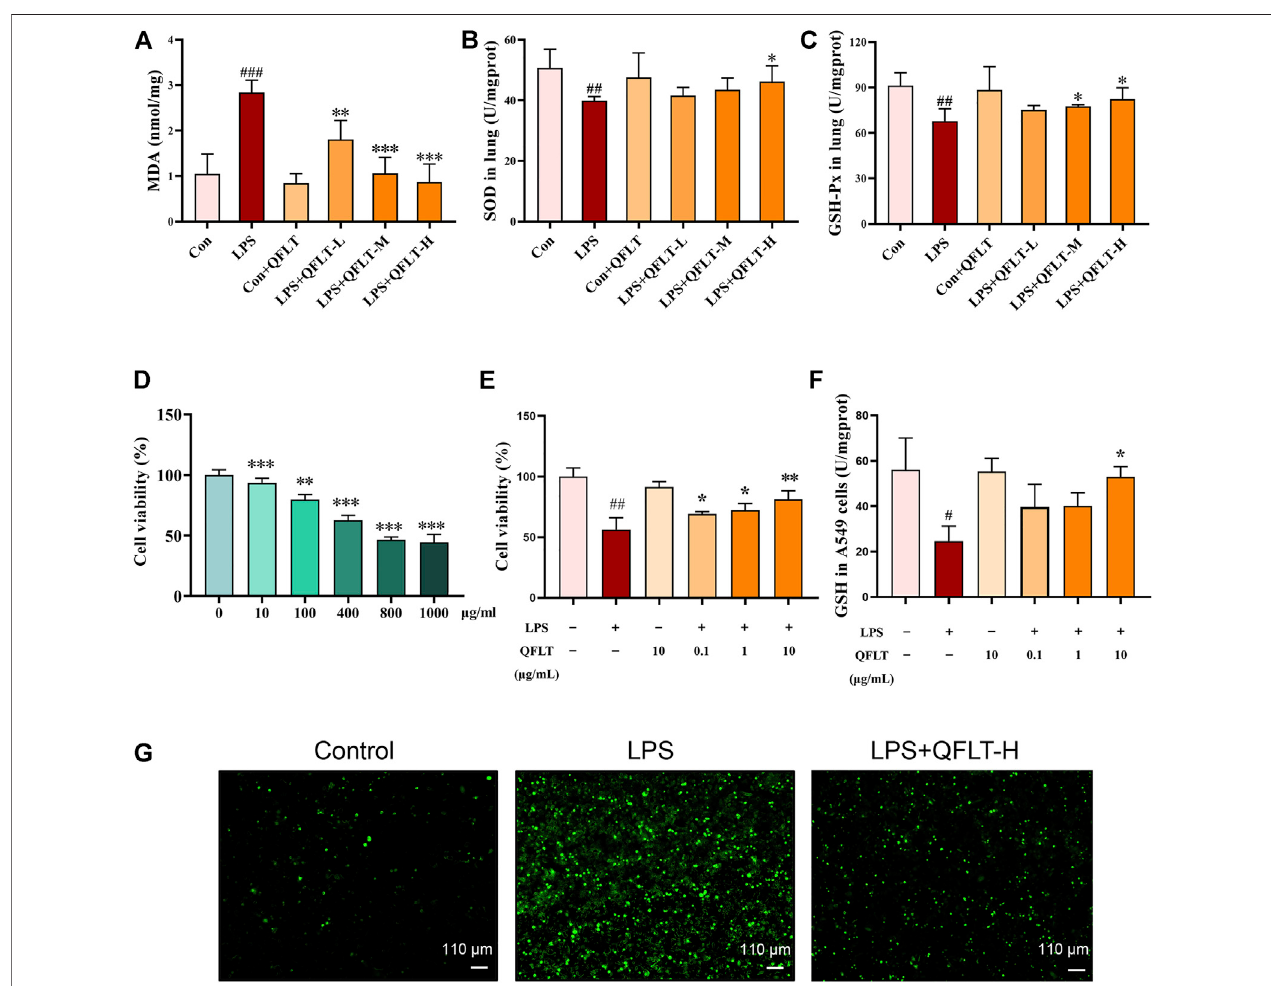
FIGURE 10 | Effects of QFLT treatment on oxidative stress in vivo and in vitro . QFLT treatment reduced the lung tissue levels of MDA, and levels of GSH-Px and SOD depletion in LPS-challenged mice (A – C) . Effects of QFLT treatment on LPS-activated cell viability and oxidation production in vitro (D – G) . (D) Different concentrations (0 – 1,000 μ g/ml) of LPS-activated A549 cells. (E) A549 cells were in the absence or presence of different concentrations with QFLT (0, 0.1, 1, 10 μ g/ml) pretreatment for 24 h and then incubated with/without LPS (800 μ g/ml) for 24 h (F) QFLT pretreatment may increase GSH levels in LPS-activated A549 cells (G) QFLTpretreatmentreduced ROSgenerationin LPS-activated A549cells asdetected using aROSkit (×4). Datawere shown asthe mean ±SD ( n =3). # p < 0.05 vs. the control group; * p < 0.05 vs. the LPS